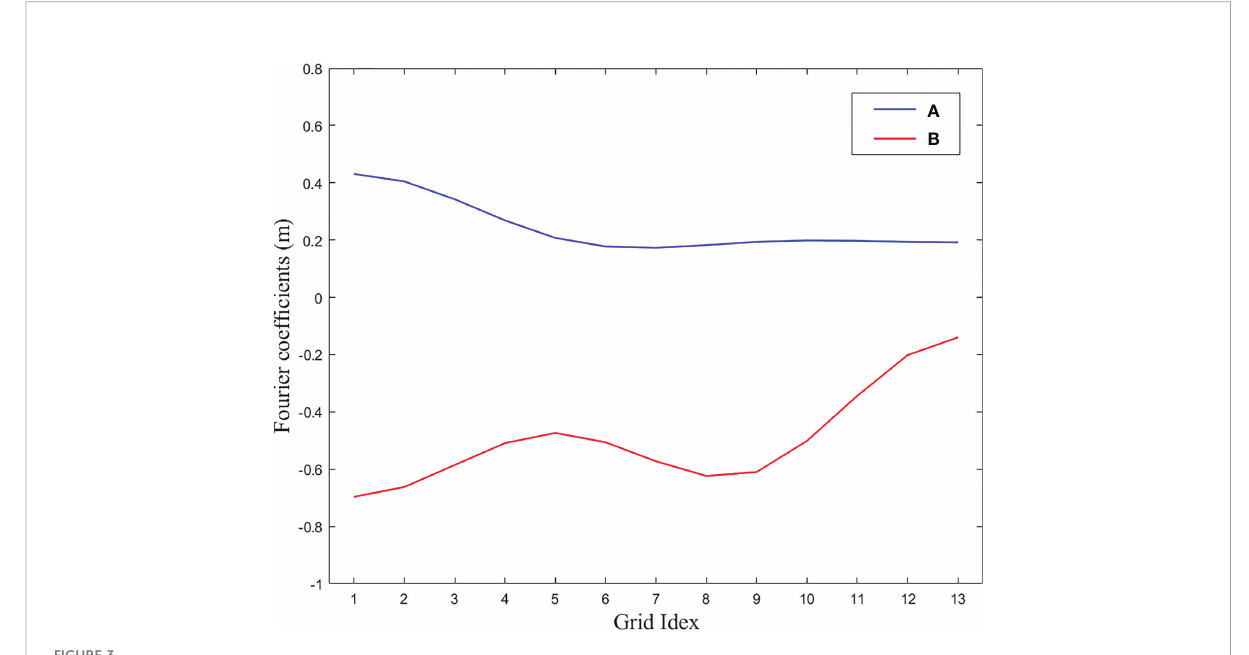
FIGURE 3 Estimated Fourier coef fi cients of OBCs for M 2 constituent in the Bohai